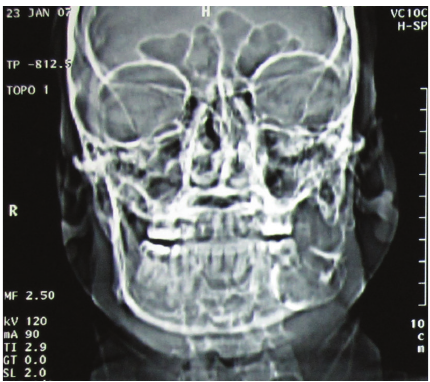
Figure 1: OPG of the involved site showing areas involved and bone destruction. Figure 2: Coronal section of CT with visible buccal bone